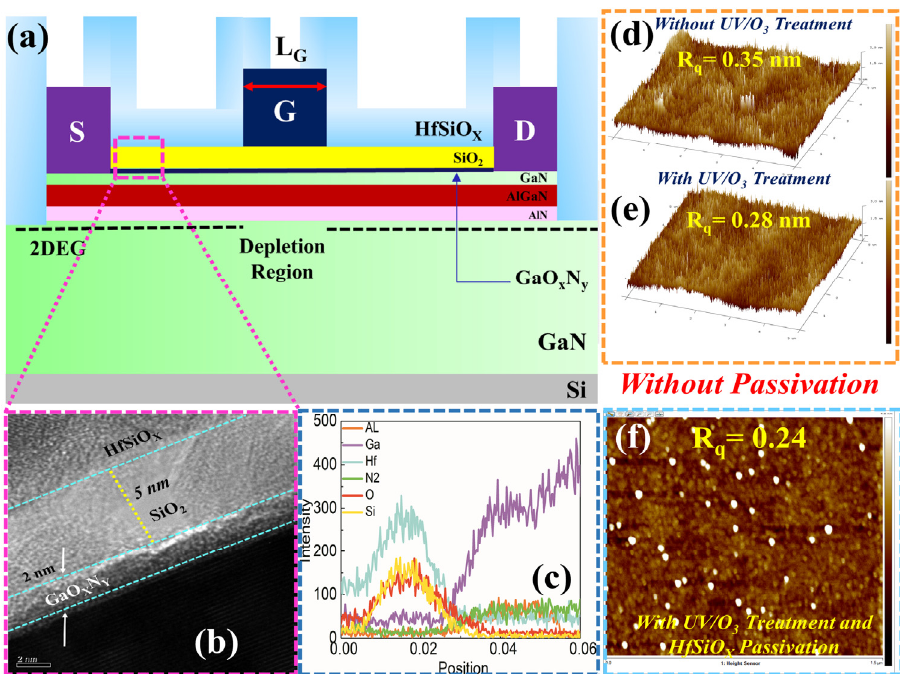
Figure 1. ( a ) Schematic illustration and ( b ) TEM image of ultraviolet-ozone (UV/O 3 )-treated HfSiO X passivated metal-oxide semiconductor high-electron mobility transistors (MOS-HEMT). ( c ) EDX line scan of HfSiO X . AFM image of MOS-HEMT ( d ) without UV/O 3 , ( e ) with UV/O 3 treatment before passivation, and ( f ) with UV/O 3 treatment after passivation.